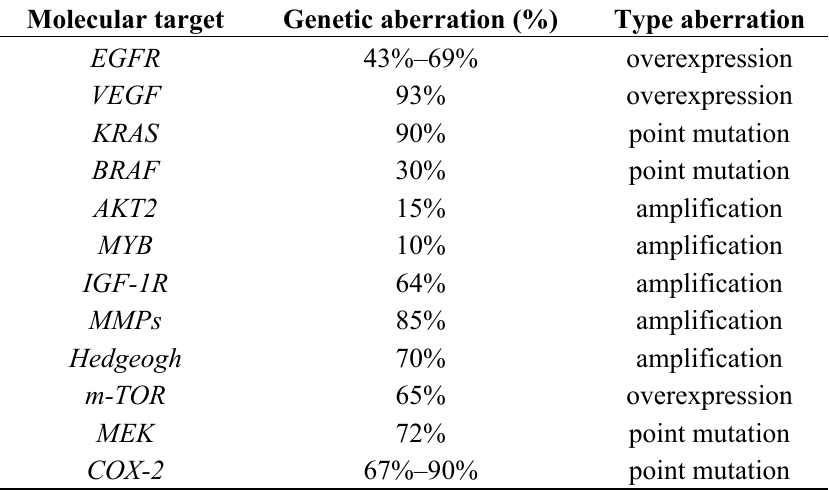
Table 1. Oncogenes in PDAC: genetic aberration percentual and type.